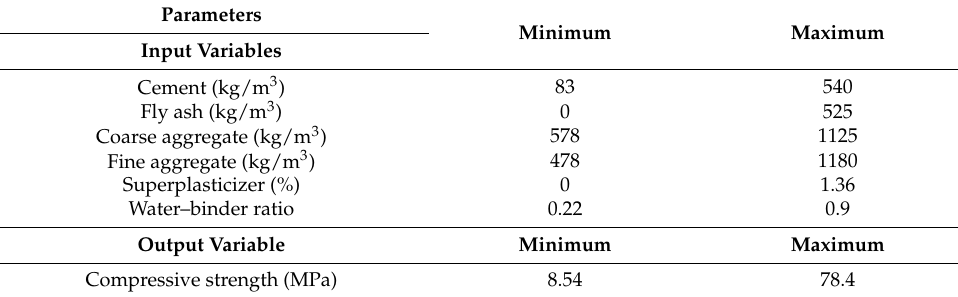
Table 4. The dataset from the latest works in the subject of concrete compressive strength prediction. Statistical Measures of Input Parameters and Output Strength in Modeling Prediction Dataset